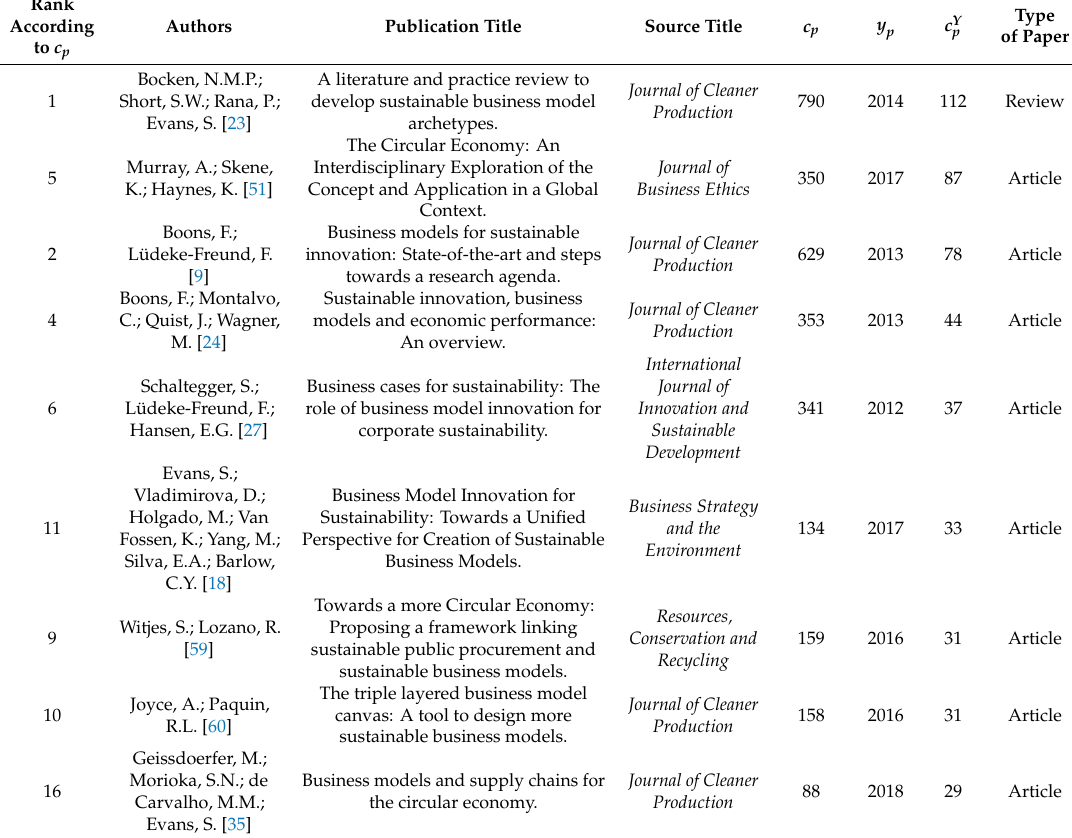
Table 8. High-impact papers in sustainable business models’ research (20 highest evaluated